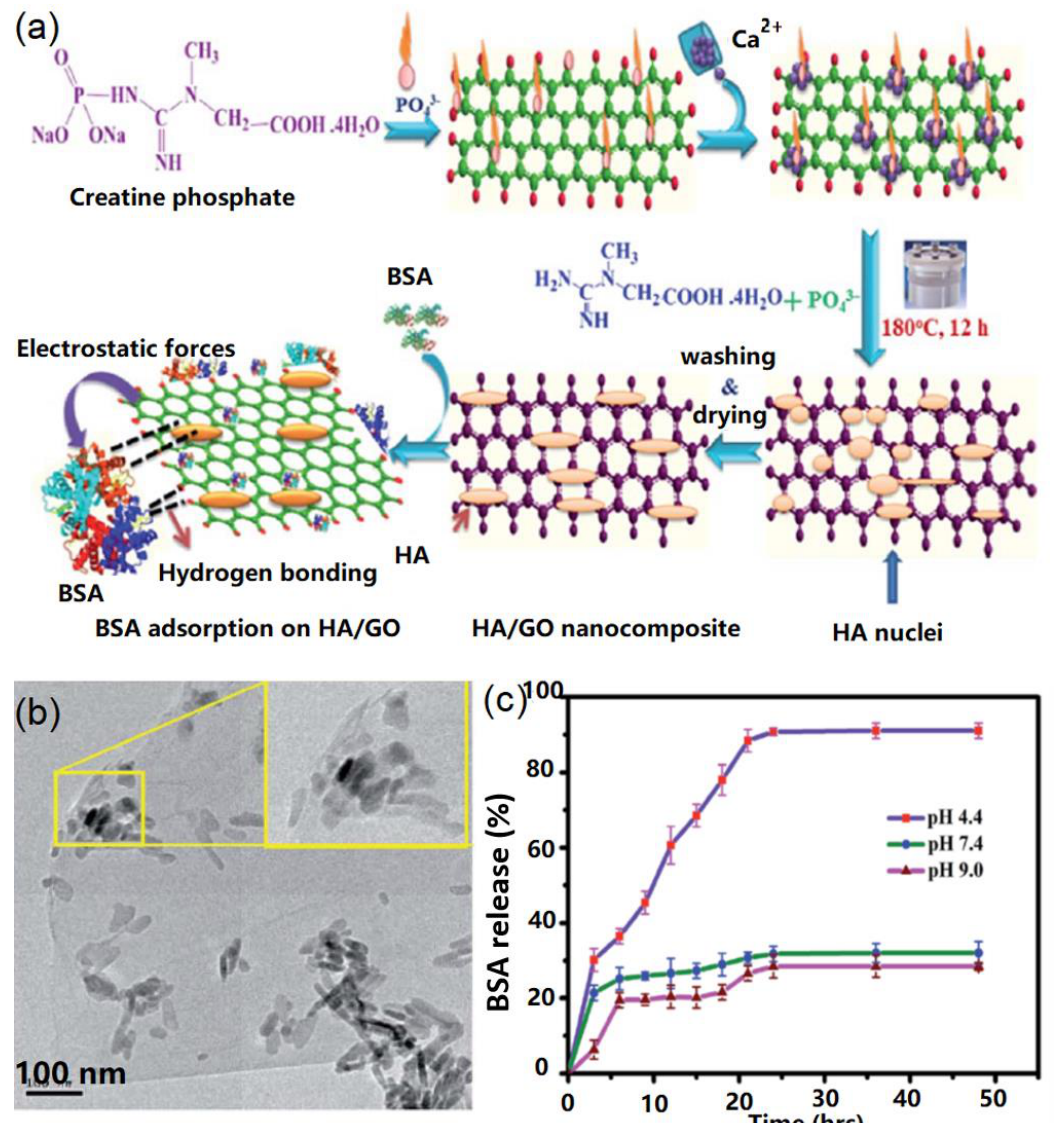
Figure 6. Biomimetic graphene-HA nanohybrids for drug delivery: ( a ) Synthesis of HA and drug delivery mechanism; ( b ) TEM image of graphene-HA nanohybrids; ( c ) drug delivery tests. Reproduced with the permission from ref. [66]. Copyright 2017 Royal Society of Chemistry.